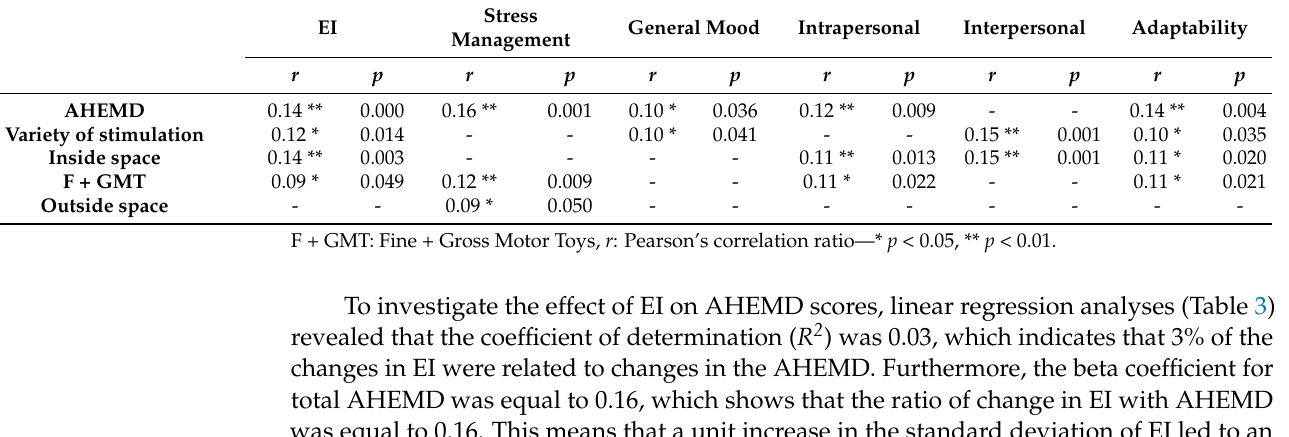
Table 2. Correlation between AHEMD and its factors with EI and its scales.